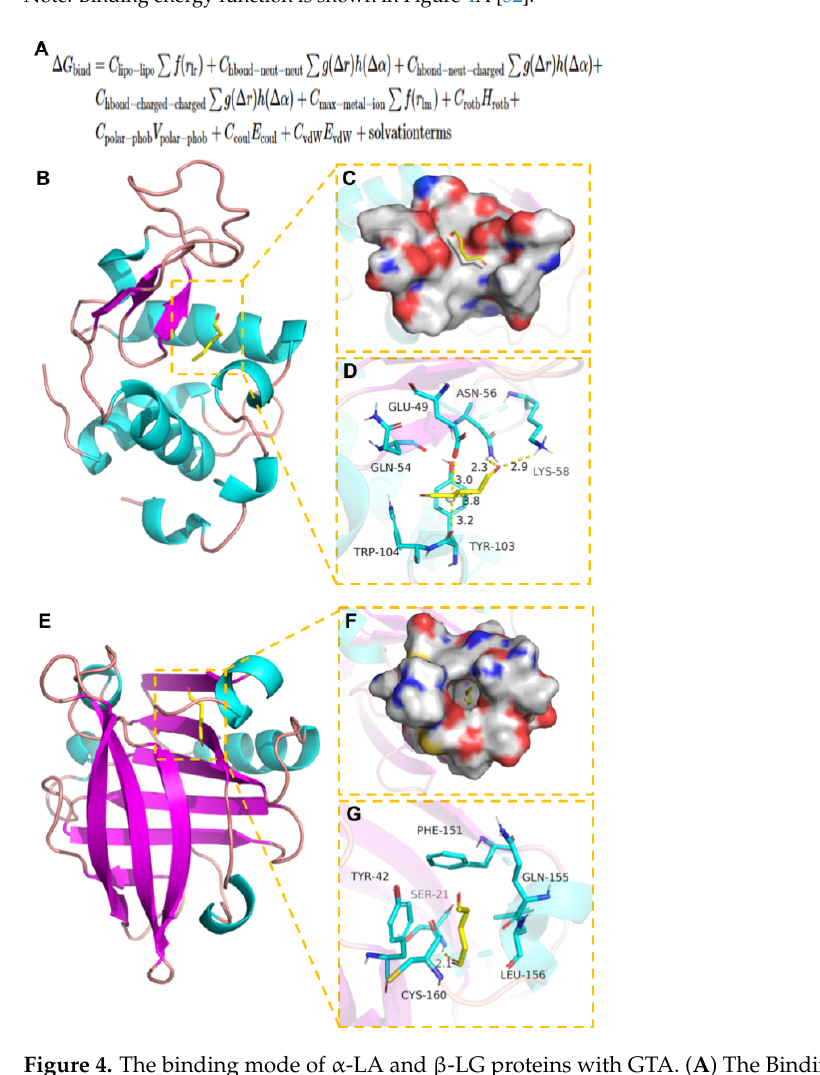
Figure 4. The binding mode of α -LA and β -LG proteins with GTA. ( A ) The Binding energy function. ( B ) The 3D structure of complex. ( C ) The surface of active site. ( D ) The detail binding mode of com- plex. GTA compound is showed in yellow. Yellow dash represents hydrogen bond distance or π - stacking. ( E ) The 3D structure of complex. ( F ) The surface of active site. ( G ) The detail binding mode of complex. GTA compound is showed in yellow. Yellow dash represents hydrogen bond distance.